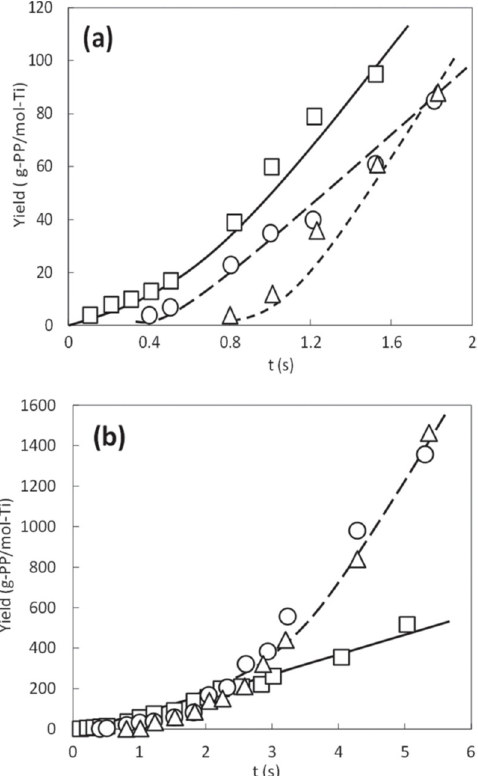
Figure 6. Propylene polymerization kinetics of a TiCl 4 /diisobutylphthalate/Mg(OEt) 2 -based catalyst at triisobutylaluminum concentrations of ( Δ ) 17.5 × 10 − 3 M, (o) 35 × 10 − 3 M, and ( □ ) 70 × 10 − 3 M: ( a ) Up to ca. 2 s; ( b ) Up to ca. 6 s [39].